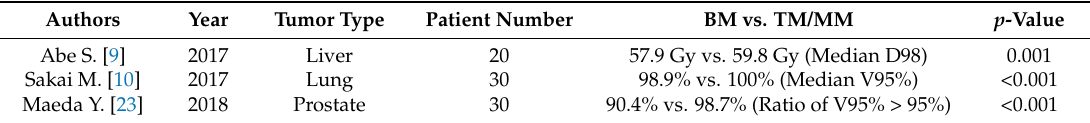
Table 1. The dose coverage of clinical target volume with different matching methods for particle therapy.